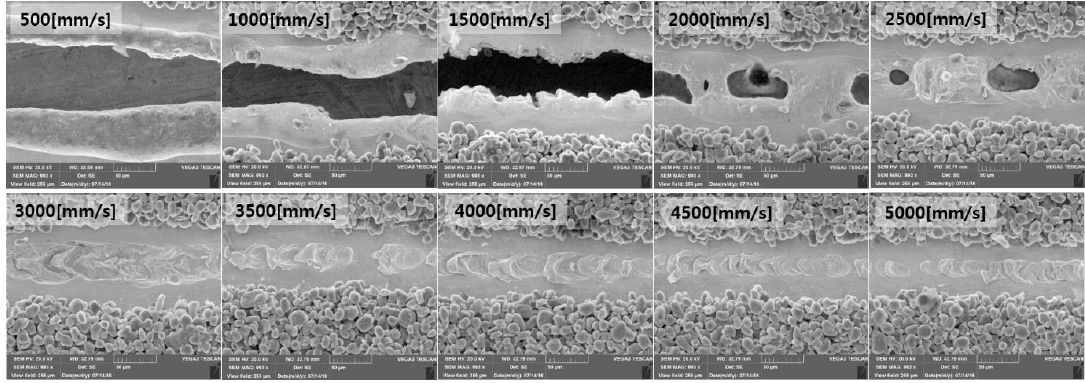
Figure 9. SEM images with a laser power of 200 W.